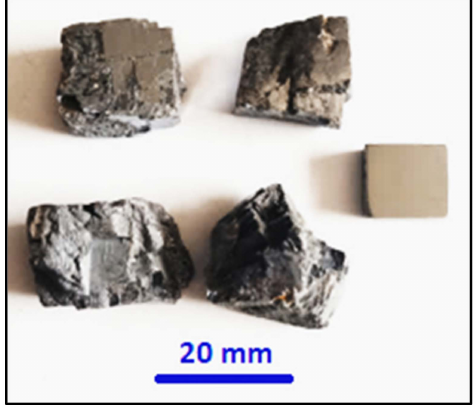
Figure 1. Some raw lumps of galena with one ground cubic shape.